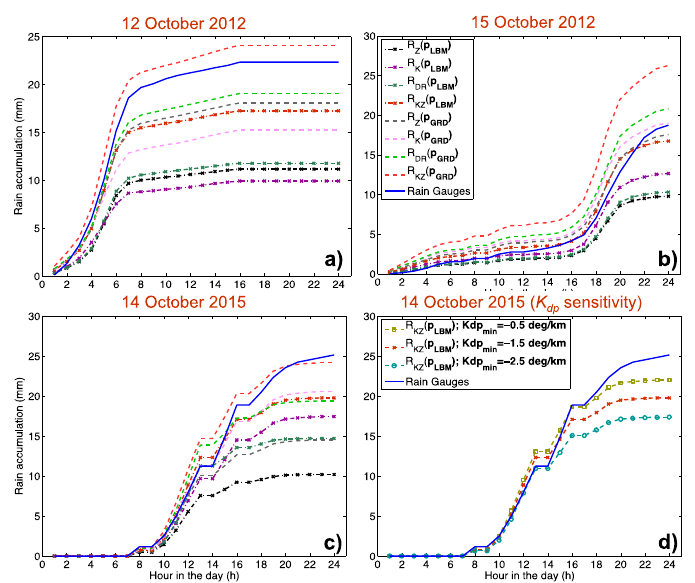
Figure 8. Scatterplots of total rain accumulation over the three case studies on 12 October 2012, 15 October 2015 and 14 October 2015 of rain gauges and radar estimates as specified in each panel’s title. Left column: implementation of Equations (1)–(4) in the main text. Right panels: the same as in the left panel after implementing Equation (7) in the main text.